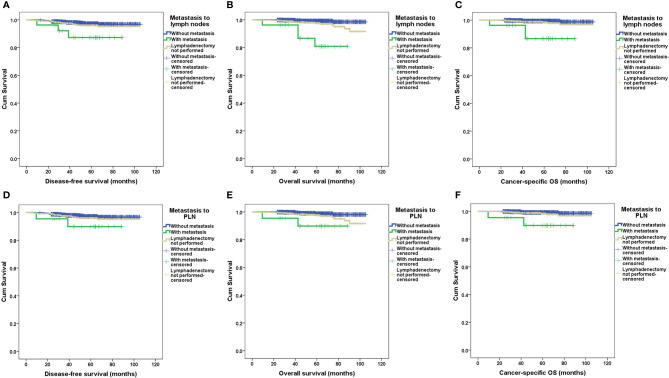
Survival outcomes between patients with and without metastasis to retroperitoneal lymph nodes by Kaplan–Meier analysis. DFS, disease-free survival; OS, overall survival; PALN, para-aortic lymph nodes; PLN, pelvic lymph nodes. (A) DFS in patients with and without metastasis to PLN and/or PALN. (B) OS in patients with and without metastasis to PLN and/or PALN. (C) Cancer-specific OS in patients with and without metastasis to PLN and/or PALN. (D) DFS in patients with and without metastasis to PLN. (E) OS in patients with and without metastasis to PLN. (F) Cancer-specific OS in patients with and without metastasis to PLN.